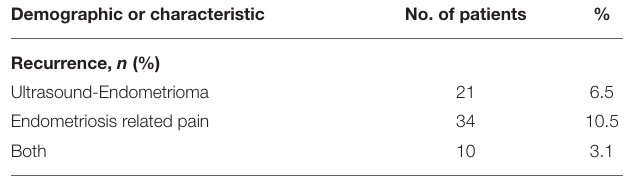
TABLE 1 | Demographic and clinical characteristics of patients with endometrioma.